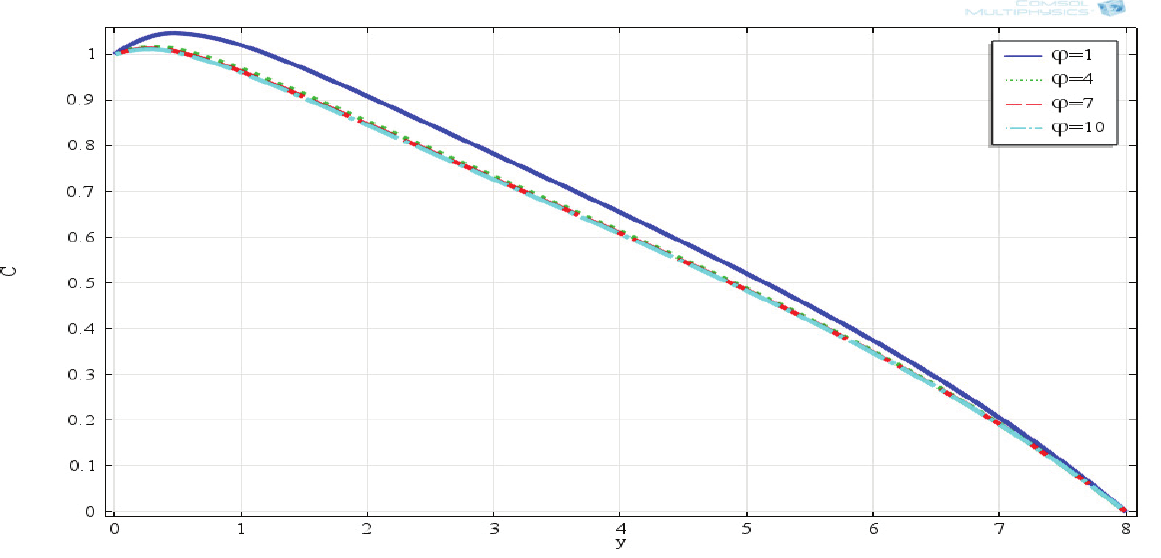
Figure 13: Steady state concentration profiles for different values of ϕ